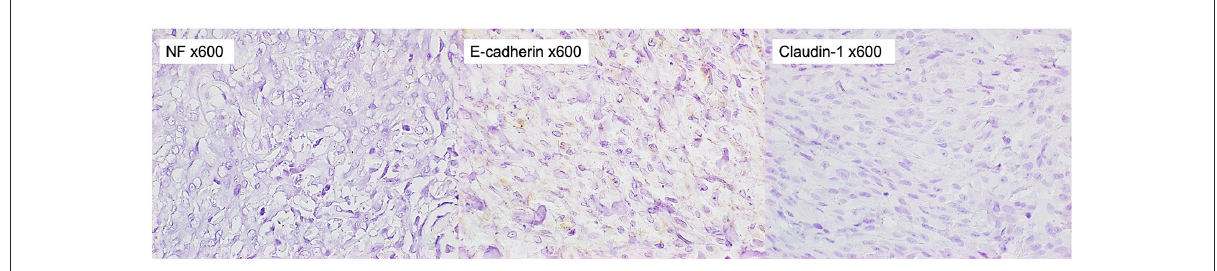
FIGURE6 Immunohistochemical staining of the tumor. The tumor cells were stained negatively for NF, E-cadherin, and Claudin-1 (x 600).